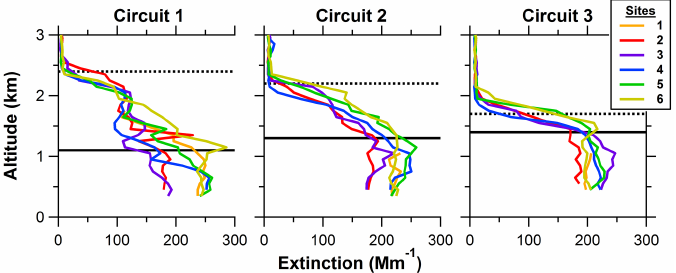
Figure 3. Vertical profiles of aerosol extinction (at ambient RH and 532nm) for flight 9 segregated by circuit and profile site. Horizontal lines represent the boundary layer (solid line) and buffer layer (dashed line) heights during each circuit at site 2 based on airborne measurements of the potential temperature profile.